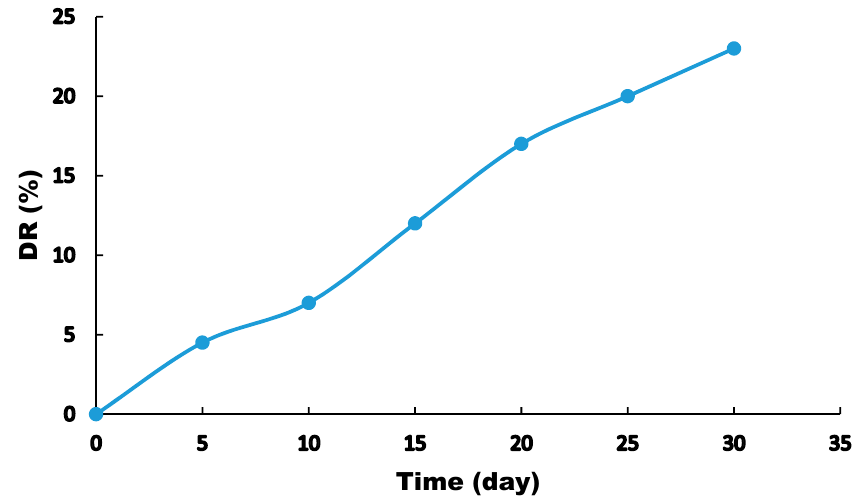
Figure 11. Degradation rate of IPNCB in the soil.